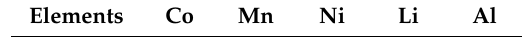
Table 1. Chemical composition of cathodic material scrap of lithium-ion battery (wt %).